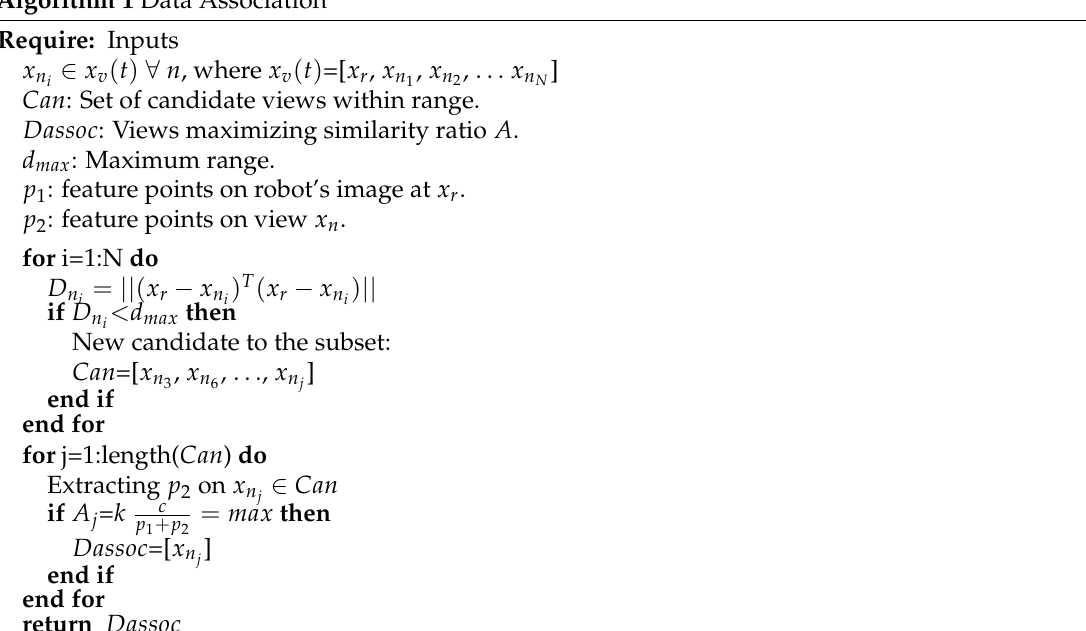
Figure 11. Data association problem with low parallax. Algorithm 1 Data